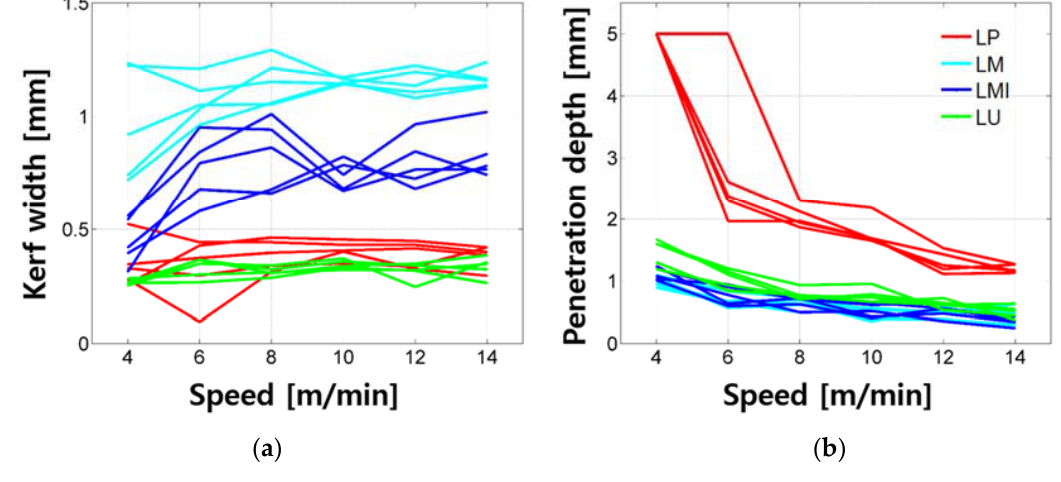
Figure 15. Comparison of kerf width ( a ) and penetration depth ( b ) based on the composition. Second, differences in the kerf width among the LP, LM, LM1, and LU series can be clearly observed. The LM series shows the widest kerf width and the kerf width decreases in the order of the LM1, LP, and LU series. However, there is a slight overlap between the kerf widths of the LP and LU series. The penetration depth also shows differences among the LP, LM, LM1, and LU series. The penetration depth of the LP series shows the deepest penetration depth and complete cutting achieved, and the penetration depth decreases in the order of the LU, LM1, and LM series. There is a slight overlap between the penetration depths of the LM and LM1